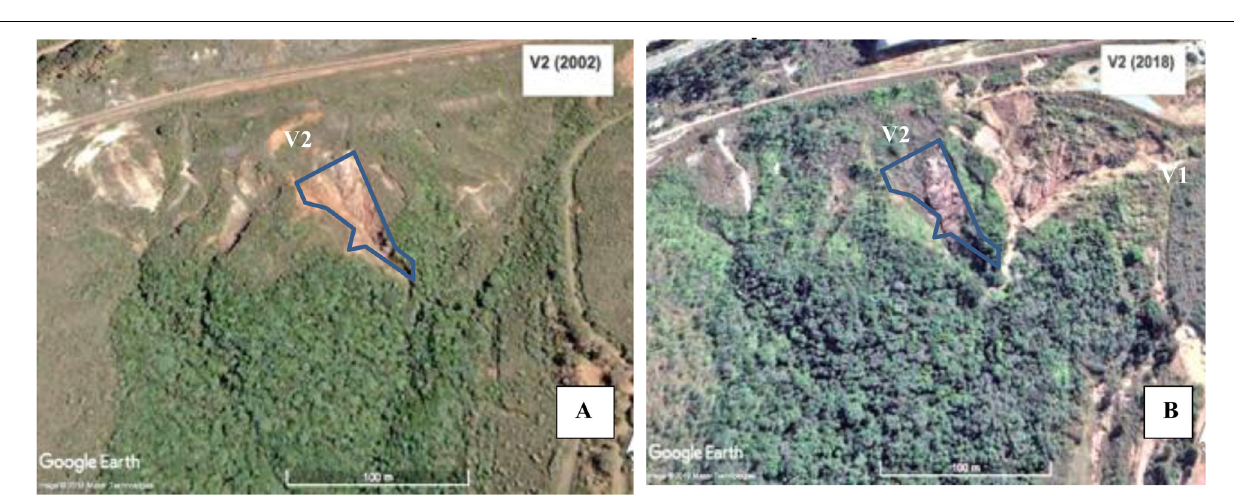
FIGURE 11 | Evolution of Gully V2. (A) Incision of V2 gully in 2002 and (B) V2 in 2018, with V1 on its right side; gully V2 - delimited in blue. Source: Adapted from Google Earth,